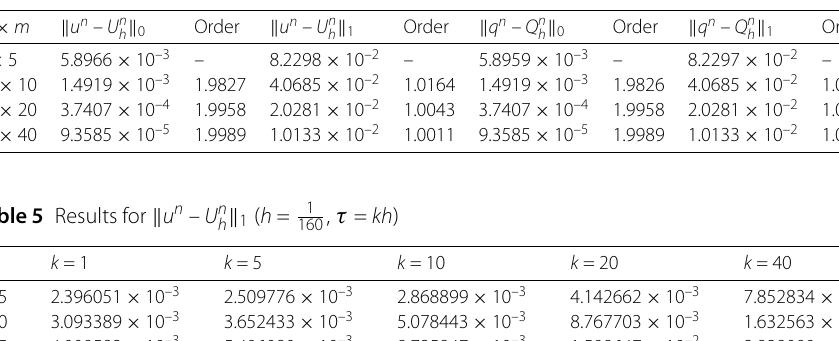
and Q n when t = 1.0 ( τ = 5 h 2 ) h h